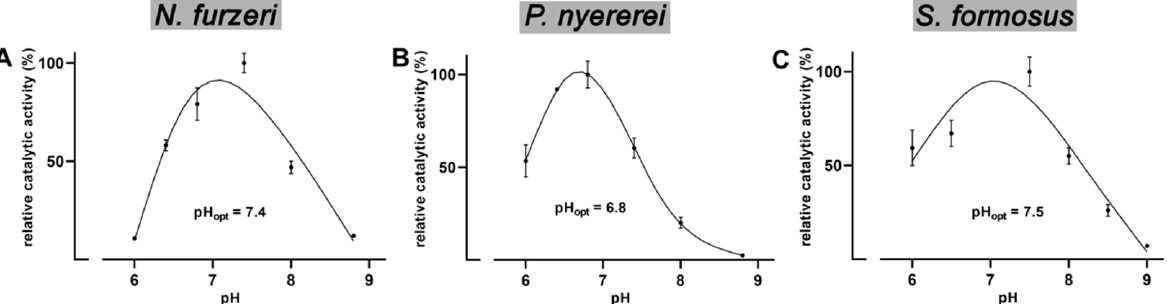
Figure 6. pH-dependence of AA oxygenation catalyzed by the different bony fish ALOX isoforms. The lysate supernatants were used as enzyme source and activity assays were carried out at different pH values. As reaction buffers equimolar mixtures of 10 mM phosphate buffer and 10 mM borate buffer were used and different pH-values were adjusted with 5 N HCl or 5 N NaOH at room temperature. The amounts of ALOX products formed during a 3 min incubation period were quantified by RP-HPLC Two independent activity assays were carried out at room temperature at each pH and means and error bars are indicated. The catalytic activity at pH opt for each enzyme was set 100%. ( A ) N. furzeri , ( B ) P. nyererei , ( C ) S. formosus . Correlation coefficients R 2 > 0.9 (R 2 for N. furzeri = 0.971, R 2 for P. nyererei = 0.986, R 2 for S. formosus = 0.951).